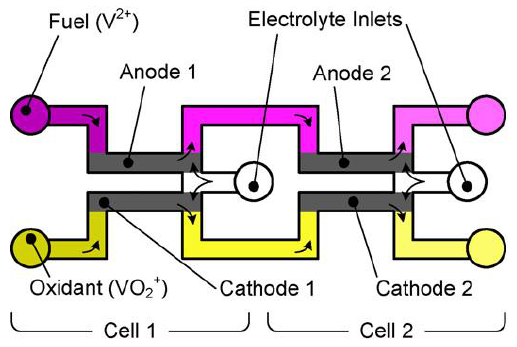
Figure 6. Microfluidic fuel cell array [17], Copyright Elsevier